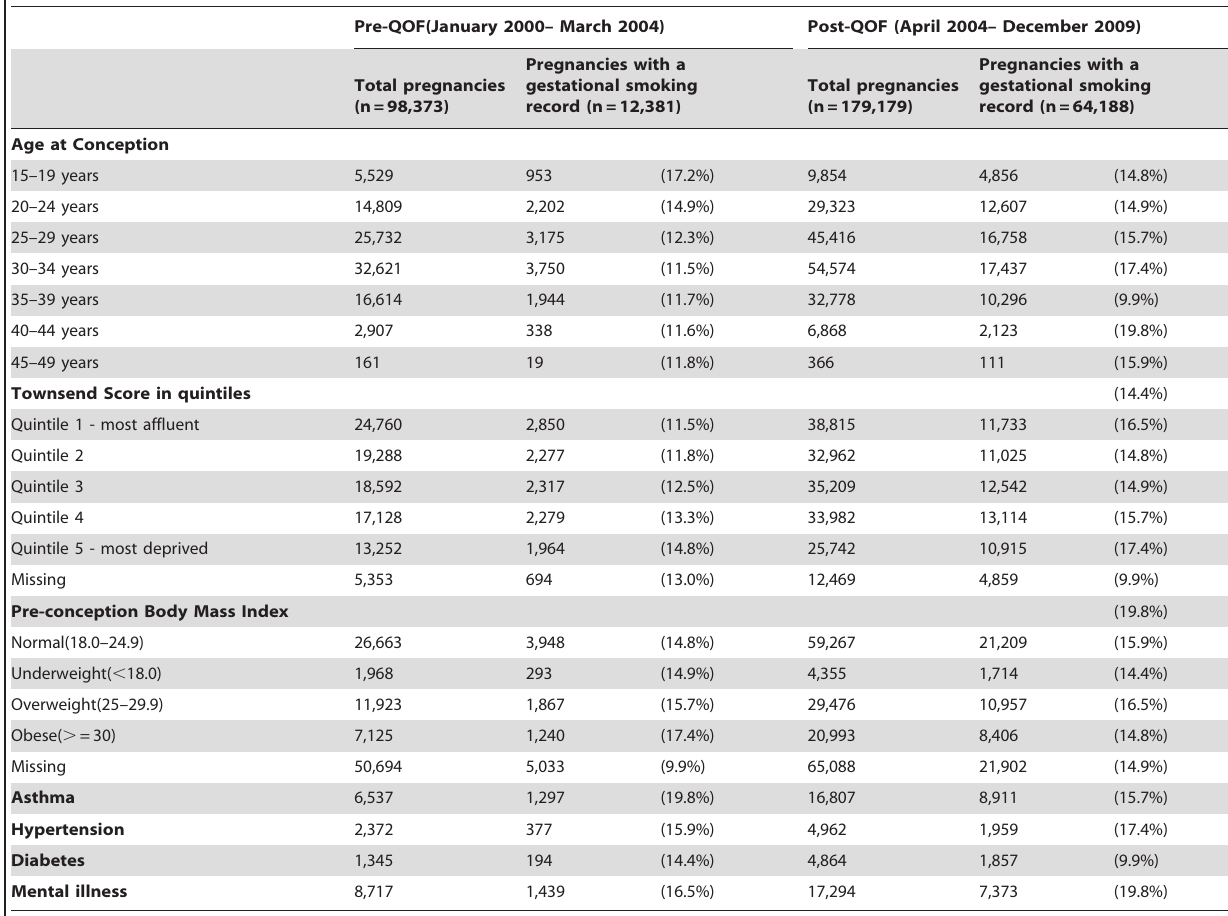
Table 1. Baseline characteristics of the study